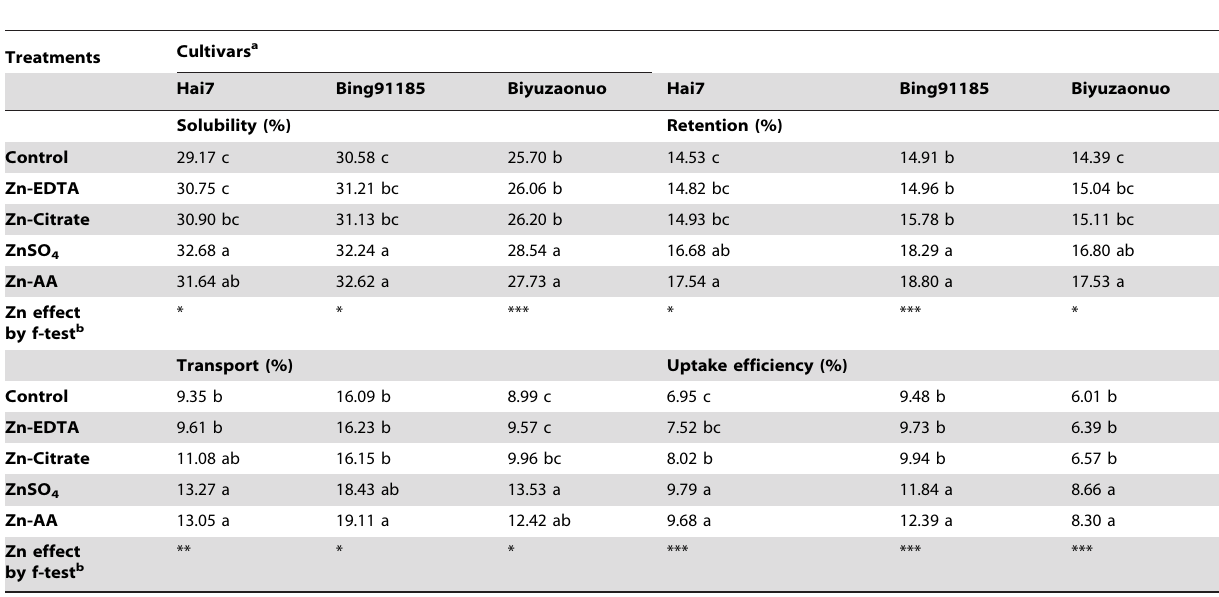
Table 4. Effect of different forms of foliar Zn fertilization on the percentages of solubility, retention, transported and uptake efficiency of Zn among three rice cultivars.